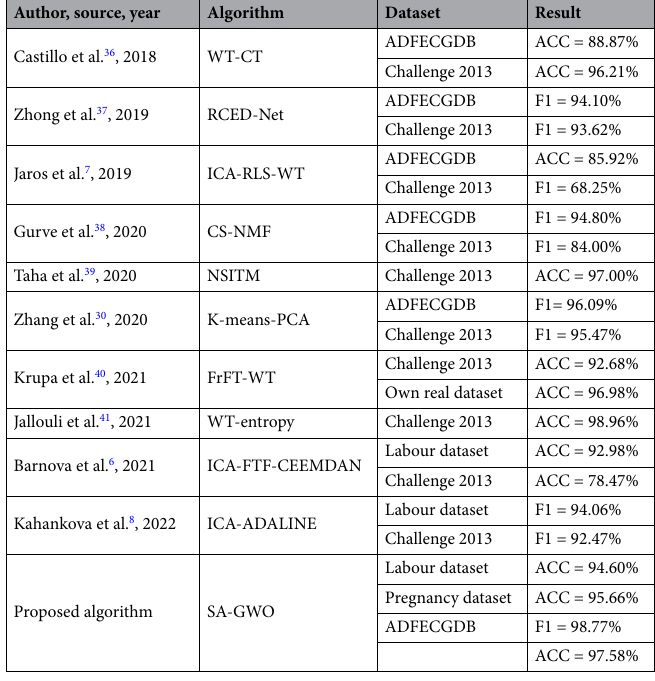
Table 4. Comparison of results with the latest studies focused on fECG